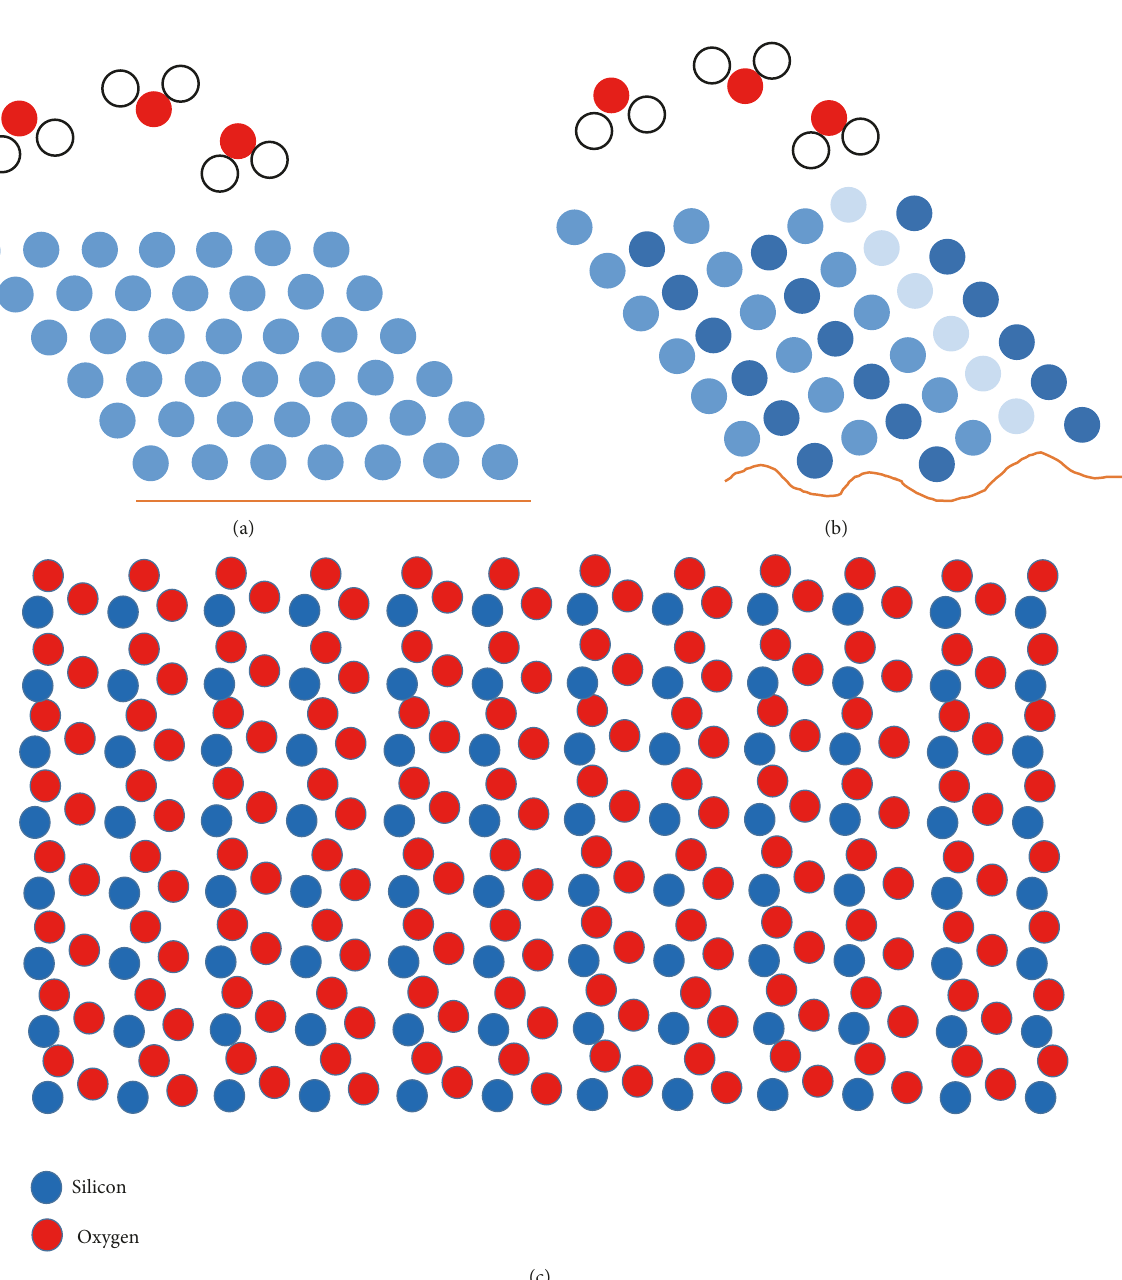
Figure 2: (a) Specular reflection, (b) roughness, and (c) atomic structure of SiO 2 on the wall surface (red denotes oxygen atoms; blue denotes silicon